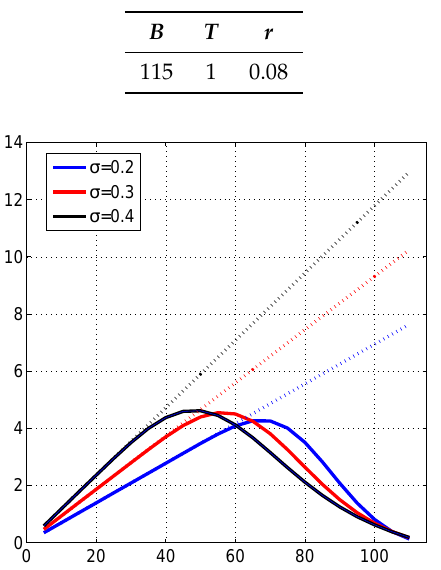
Table 7. Floating strike up-and-out call option data.